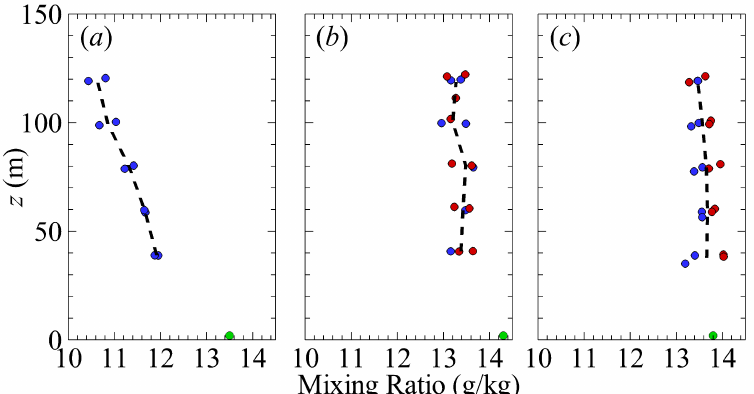
Figure 10. Vertical profiles of mixing ratio measured during ( a ) flight 1, ( b ) flight 2, and ( c ) flight 3. The blue symbols indicate measurements made by BC5A, the red symbols indicate measurements made by BC5B and the green symbols indicate measurements made by the Mesonet tower. The dashed line indicates the trend produced by averaging measurements at each